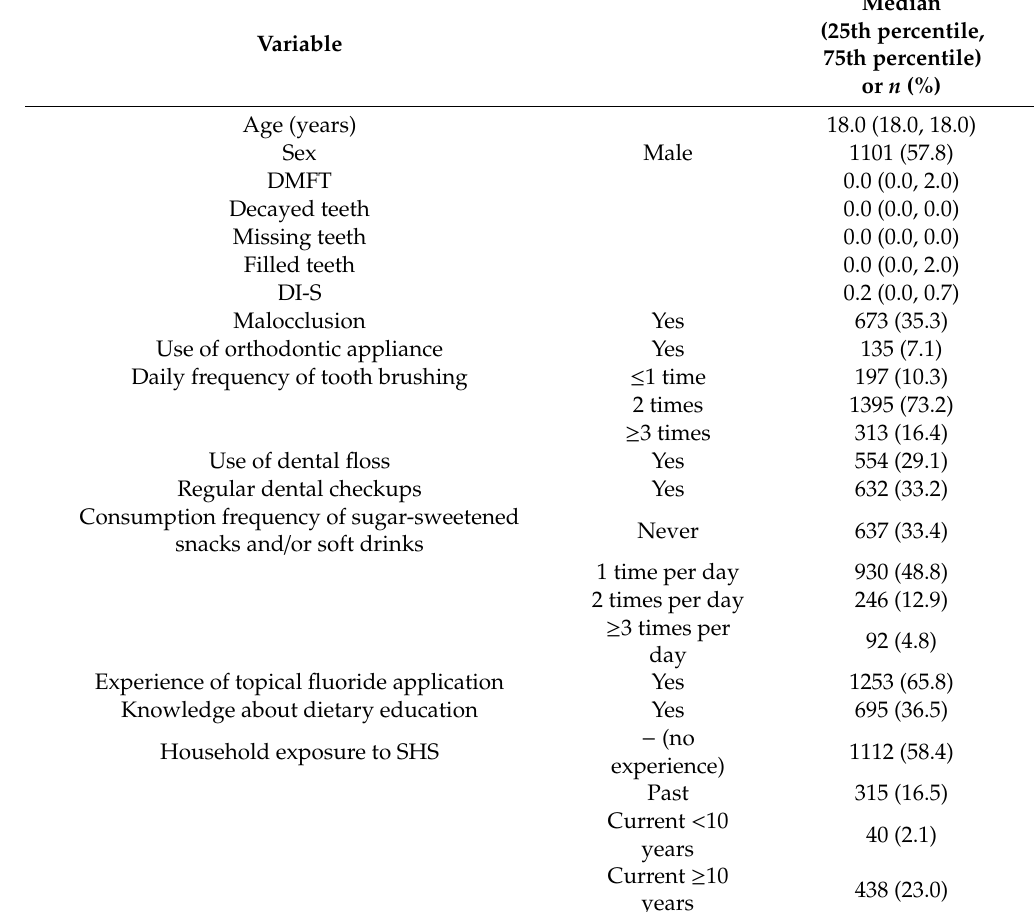
Table 1. Characteristics of participants ( n = 1905).